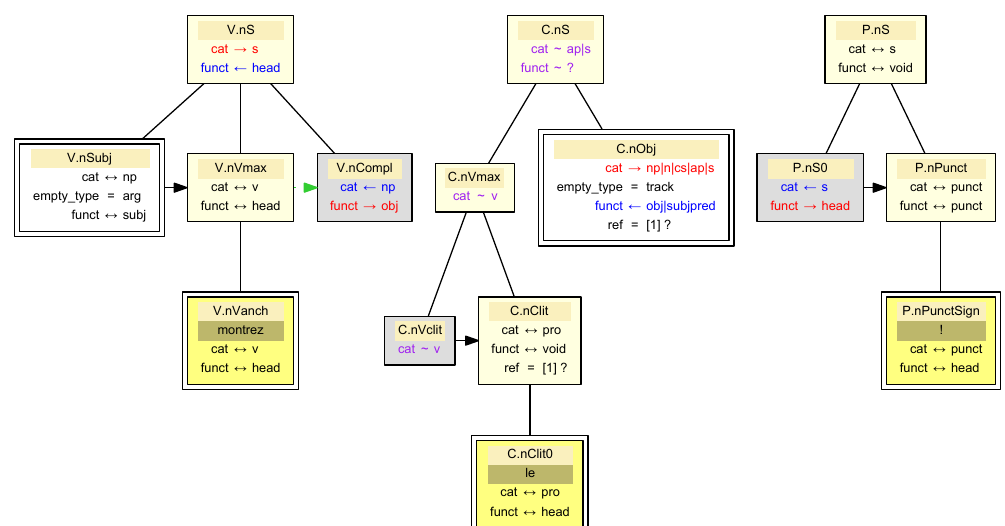
Figure 2: Polarized tree description associated with the sentence montrez-le! by the grammar